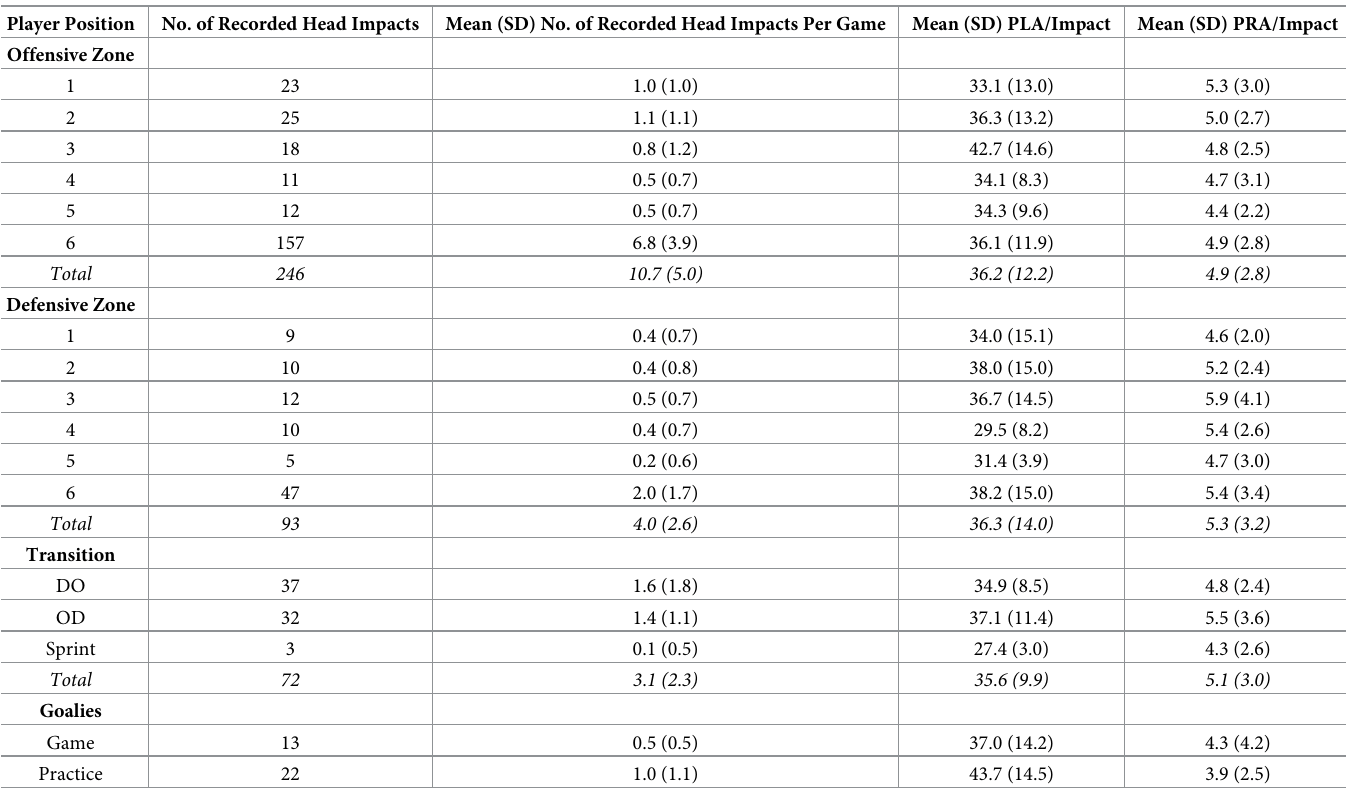
Table 1. Summary of recorded head impacts sustained by player